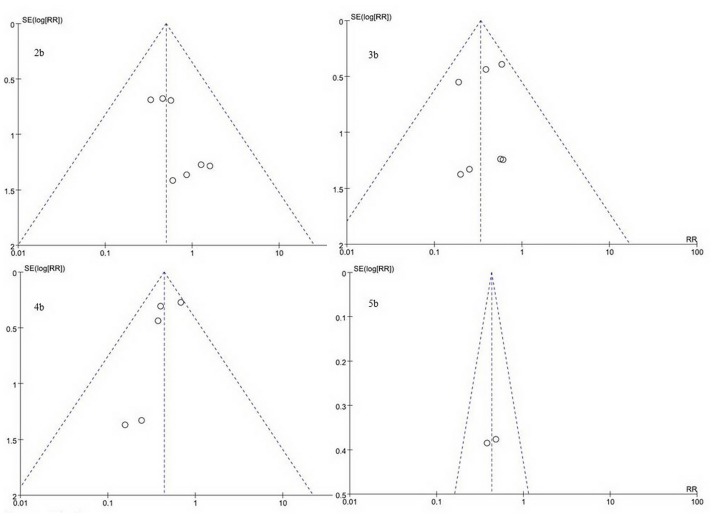
Funnel plots for publication bias of one-year OS (a), three-year OS (b), five-year OS (c), and three-year DFS (d).The vertical line indicates the pooled estimate of the overall risk ratio, with the sloping lines representing the expected 95% CI for a given standard error.